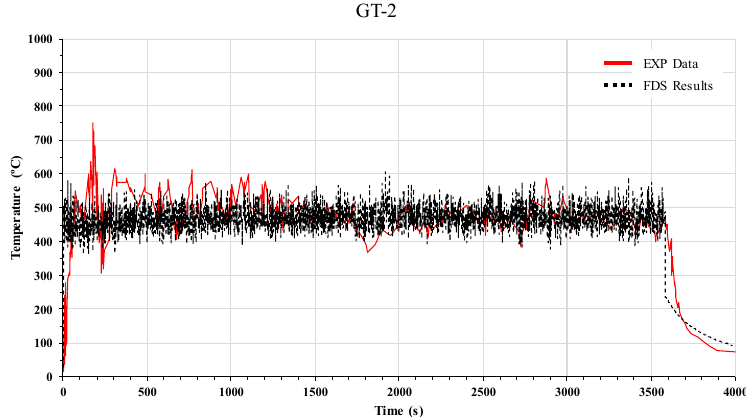
Figure 14. Gas cloud temperature over time at GT-2.